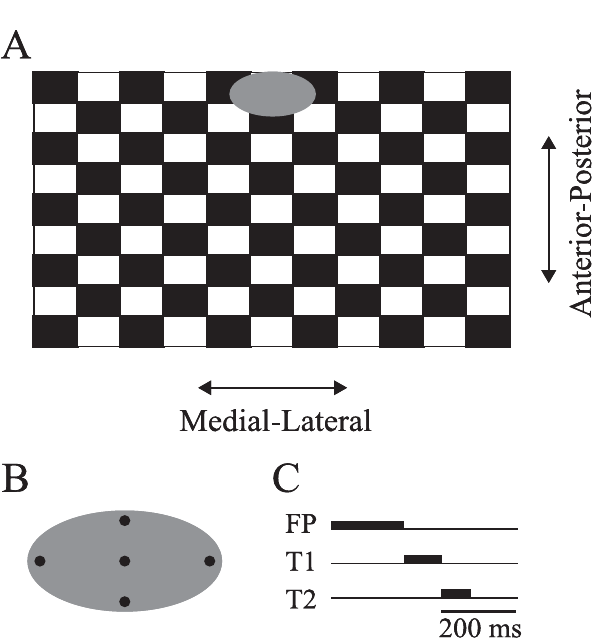
Fig 2. Visual stimuli used in the experiments. (A) Illustration of the checkerboard pattern that moved sinusoidally either in the anterior-posterior or medial-lateral direction and of the grey oval patch insidewhich gaze targets were projected. The oval patch itself did not move, so the checkerboard pattern moved “behind” the oval. (B) Positionof the gaze targets presented inside the oval patch. Note that all targets were flashedfor short durationsand that two targets were never presentedsimultaneously. (C) Timing of stimuli presentation duringa typical double-stepsaccade experiment. All saccade targets were extinguished before the onset of the 1st eye saccade. The same targets positions were used in the single-step saccade conditionand in the fixation condition.